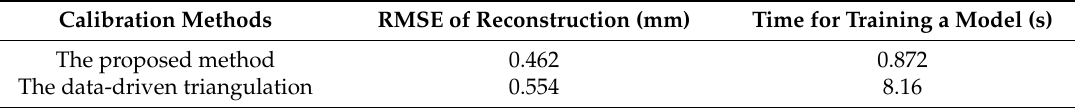
Table 3. Reconstruction of an engine blade by two different methods.